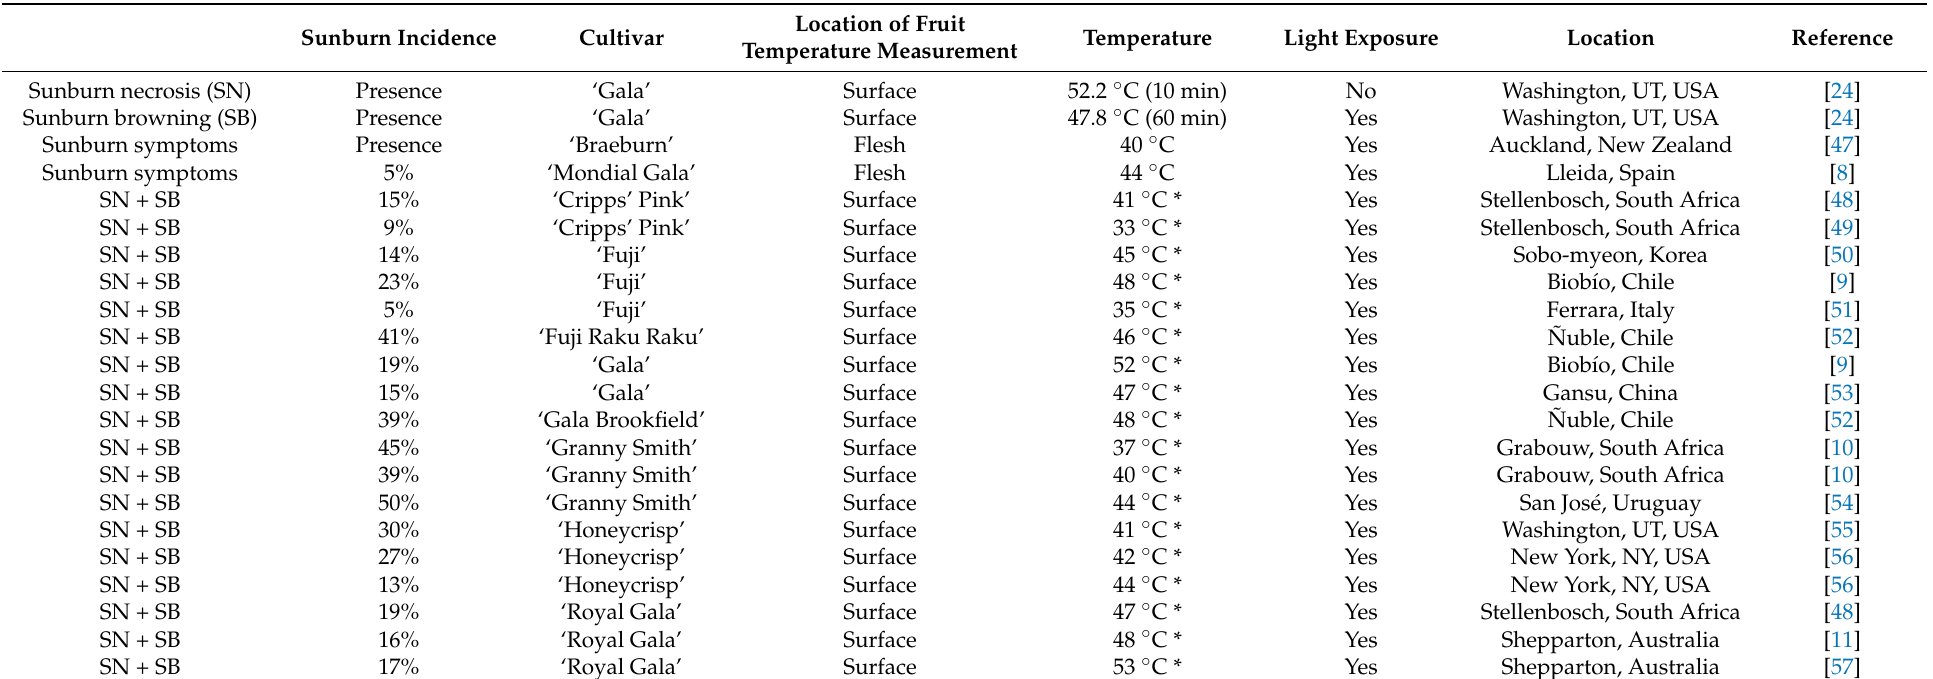
Table 1. Sunburn incidence and sunburn temperature thresholds for several apple cultivars in different locations. * Values obtained according to the